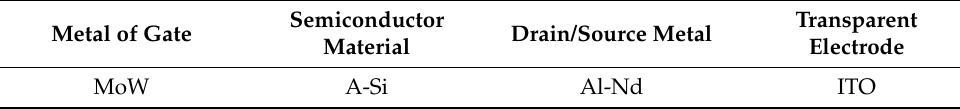
Table 1. The material parameters of a TFT substrate.